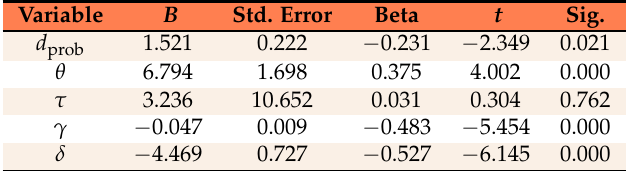
Table 5. OLS regression coefficients with N s as the independent variable.